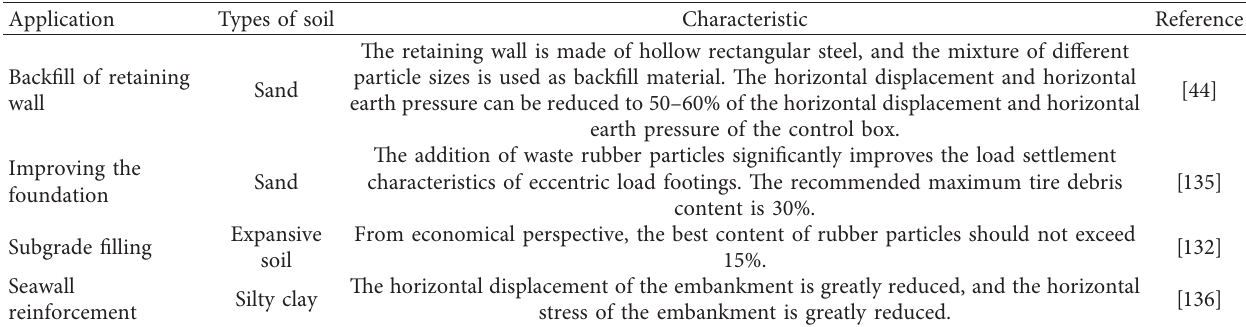
Figure 4: Recommended isolation system classification (modified from Table 8: Application of rubber reinforced soil as backfill.